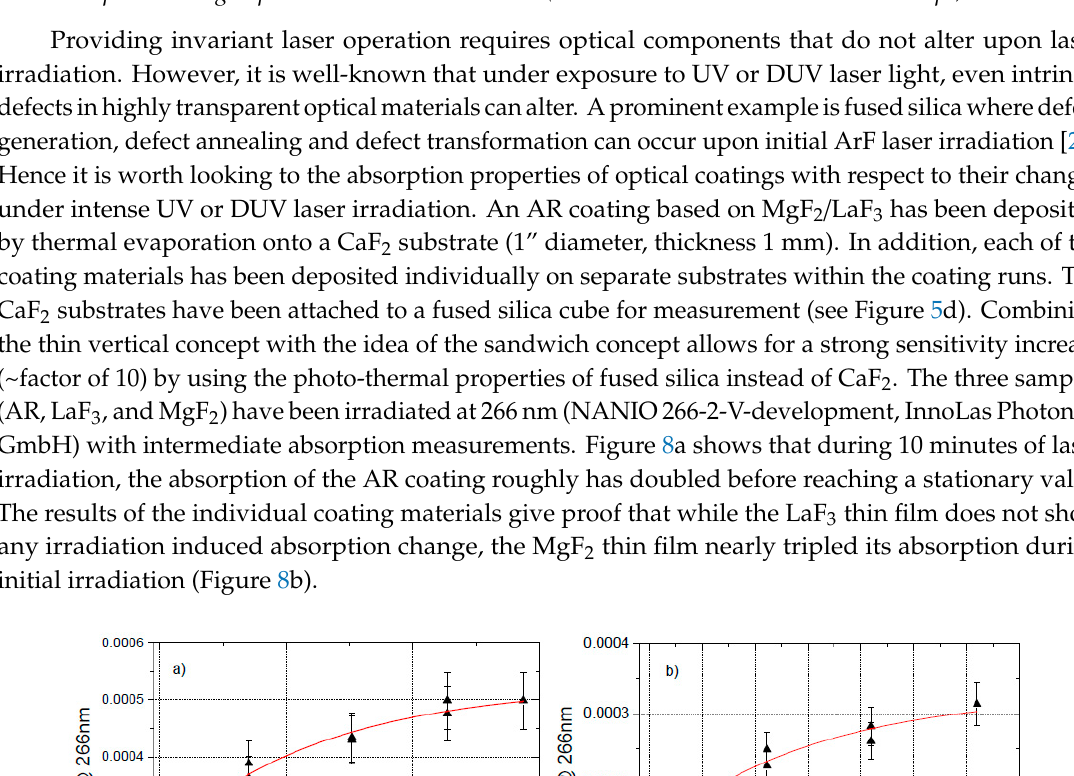
Figure 7. Absorption in HfO 2 single layers as a function of the iron concentration for the wavelengths 266 and 355 nm, respectively.